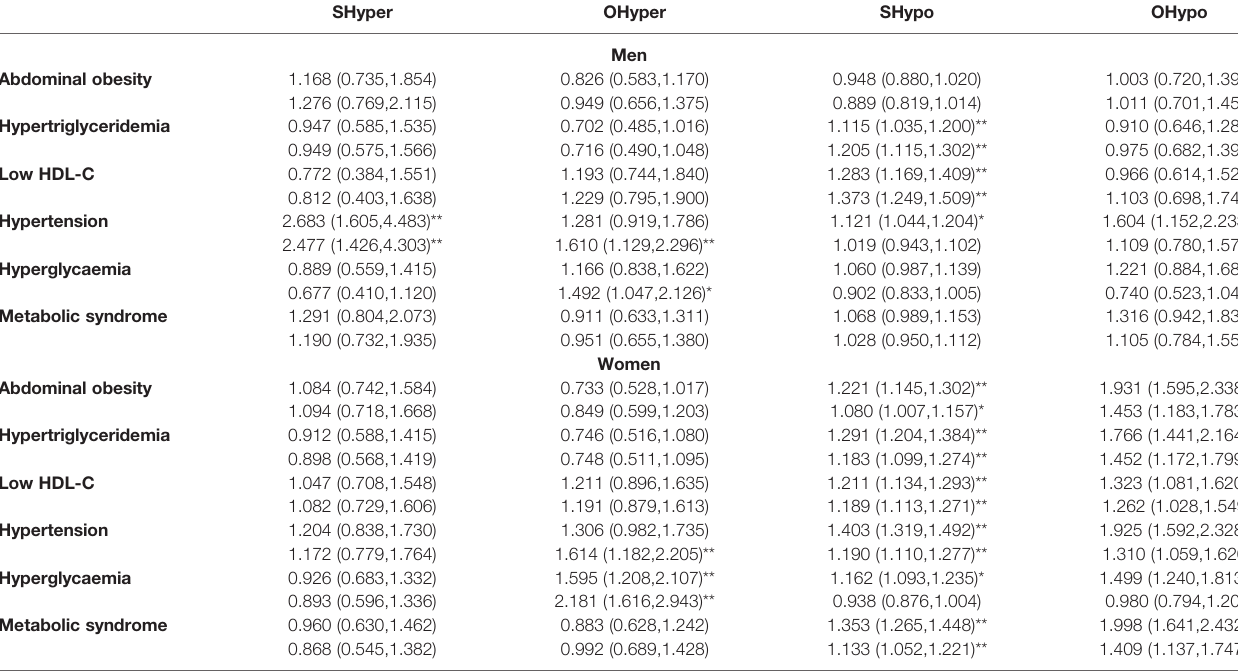
TABLE 3 | Risk of metabolic syndrome associated with thyroid function in men and women.